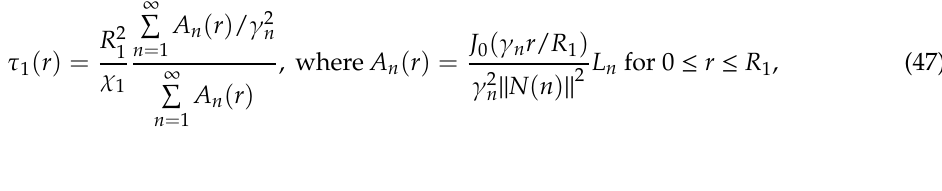
Figure 5. Distributions of local time constants with parameters ),(